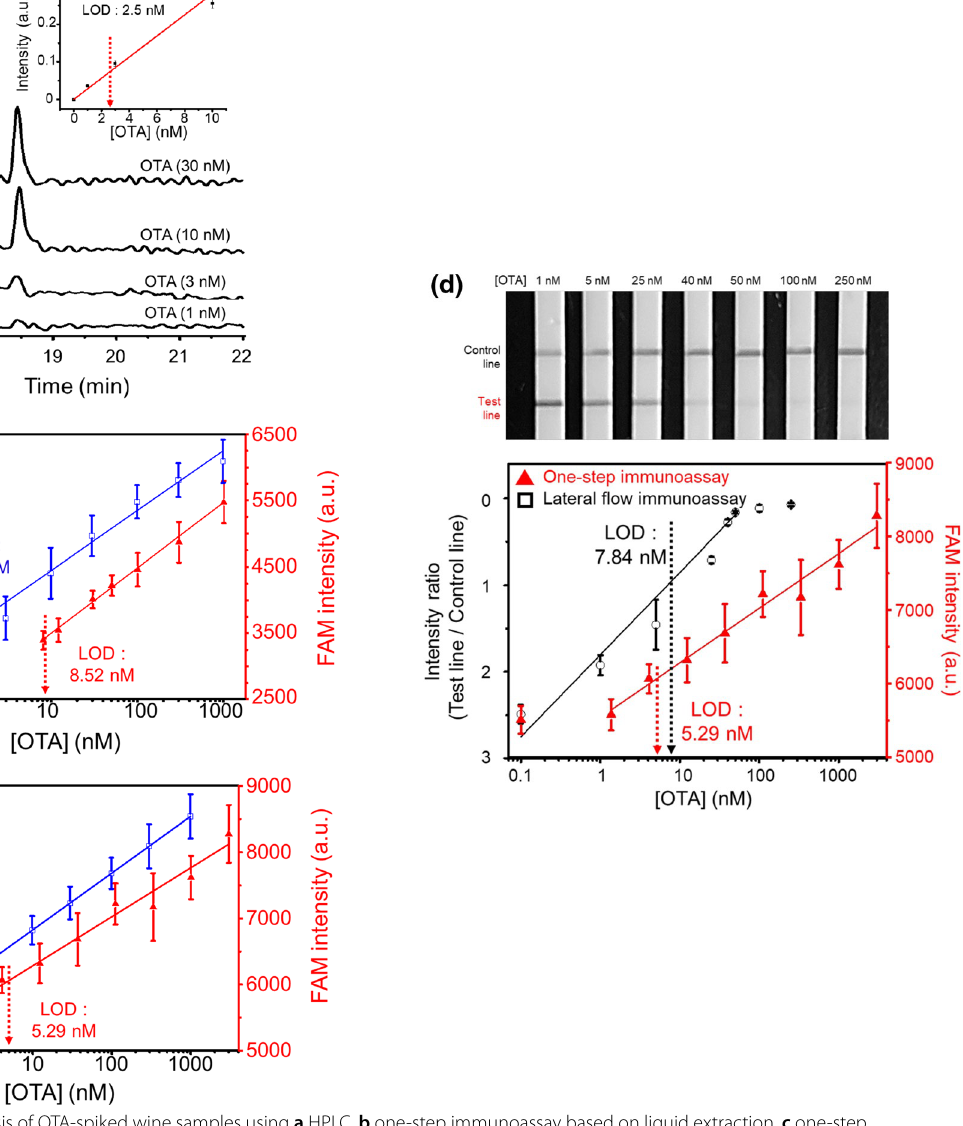
Table 3 Stability of fluorescence signal output to different ratios of wine samples Spiked OTA